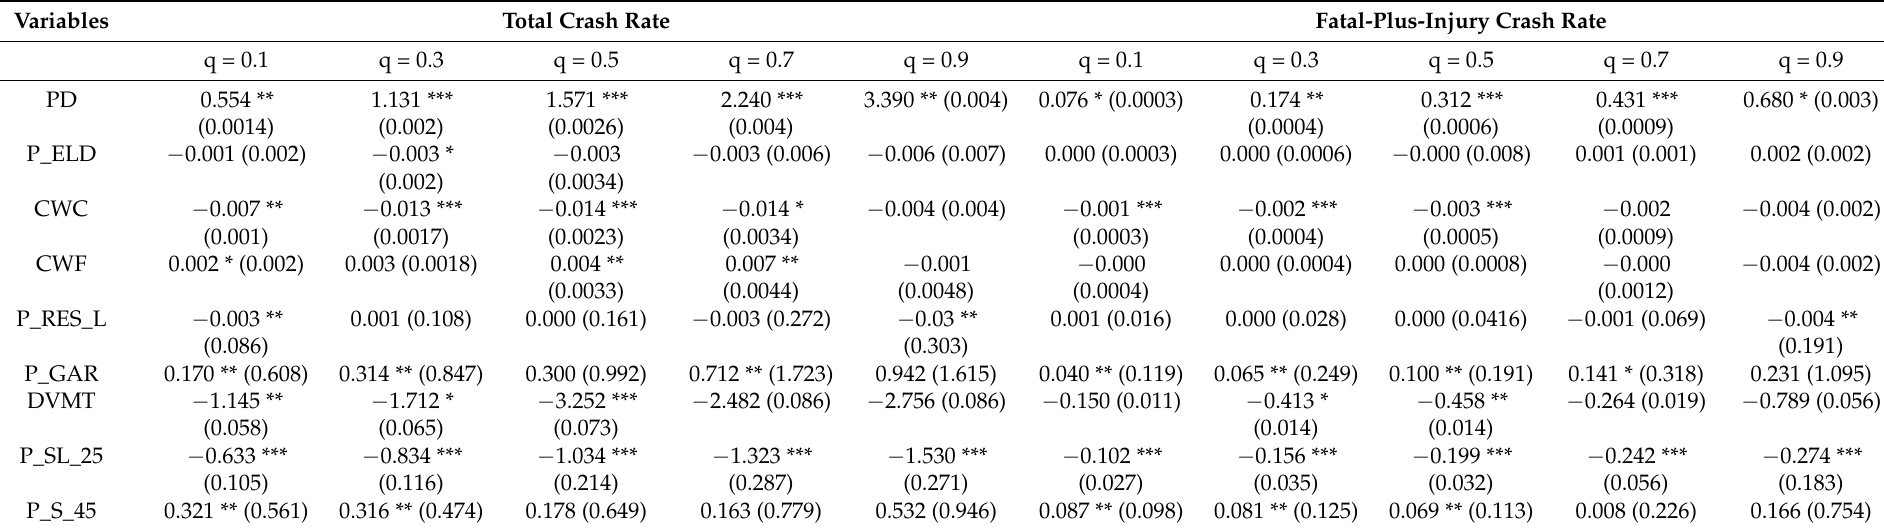
Table 2. Coefficients estimation of Spatial AR quantile